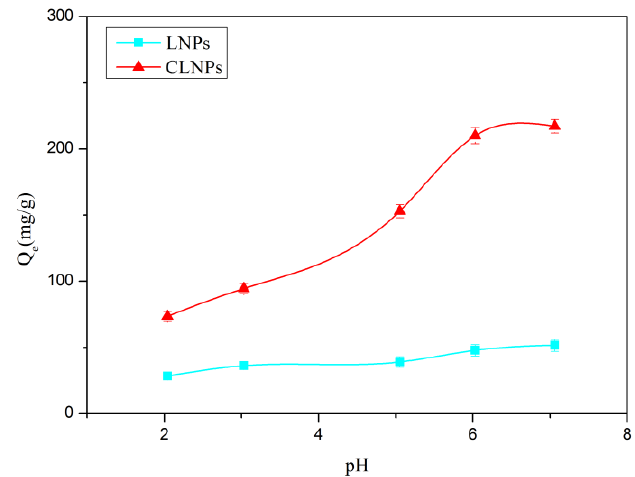
Figure 6. Effect of pH on the adsorption amount of Pb(II) by CLNPs and LNPs (dosage = 10 mg/50 mL, C 0 = 100 mg/L, t = 180 min, temperature = 30 °C).